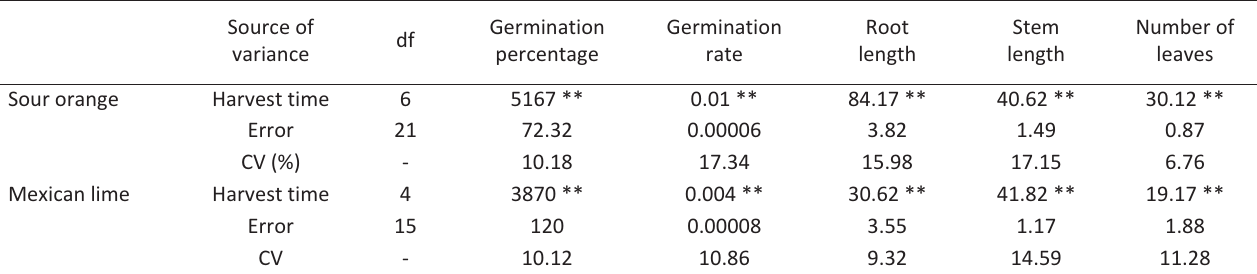
Table 1 ­ Analysis of variance of the effect of harvest time on sour orange and Mexican lime on seed germination and seedling growth in vitro condition